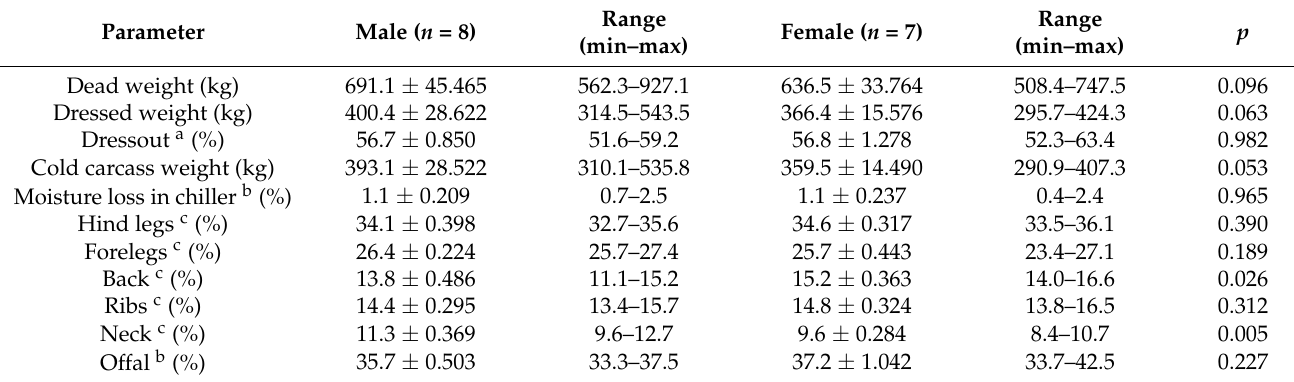
Table 3. Mean ( ± SE) carcass yields of ~3.7 years old male and female giraffe ( G. c. angolensis